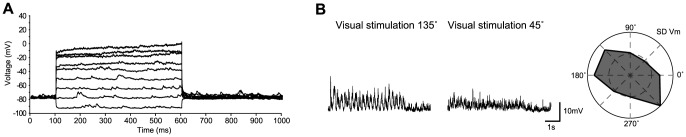
Gial cell in cat visual cortex in vivo recorded with the WS method.(A) Voltage responses to current steps (100 nA increments from −100 to 700 nA). (B) Left – Preferred (135°) and non-preferred (45°) voltage responses (average of 10 trials) to a moving sinusoidal grating (4 Hz, 100% contrast, 5 second duration). Right – Average standard deviation of the visual responses (over the 10 trials) as a function of stimulus direction, showing that this cell is tuned to stimulus orientation, with a small bias for stimulus direction. The on-line corrected Ra was 48 MΩ, which was validated off-line. The input resistance was 100 MΩ, giving a relative Ra of 0.48.